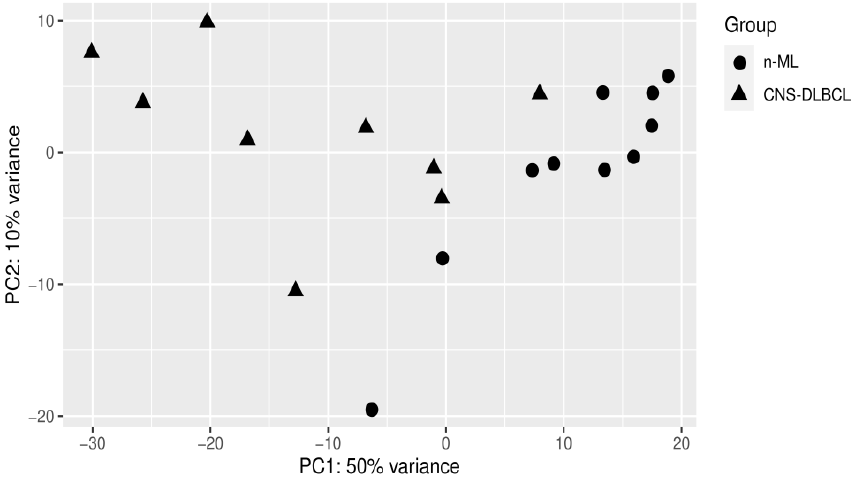
Figure 2. PCA of the tumor samples from patients with primary diffuse large B-cell lymphoma of the central nervous system (CNS DLBCL, n = 10) and with non-malignant CNS diseases (n-ML, n = 10).